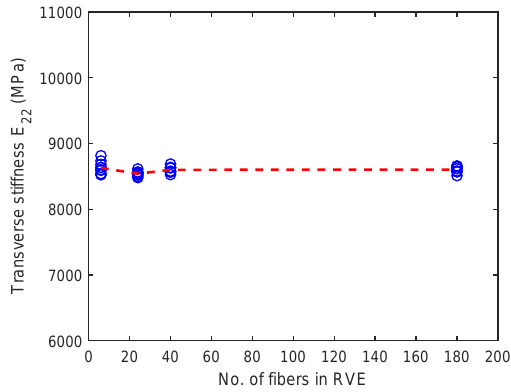
Figure 16. Variation of transverse stiffness with unit cell size with V